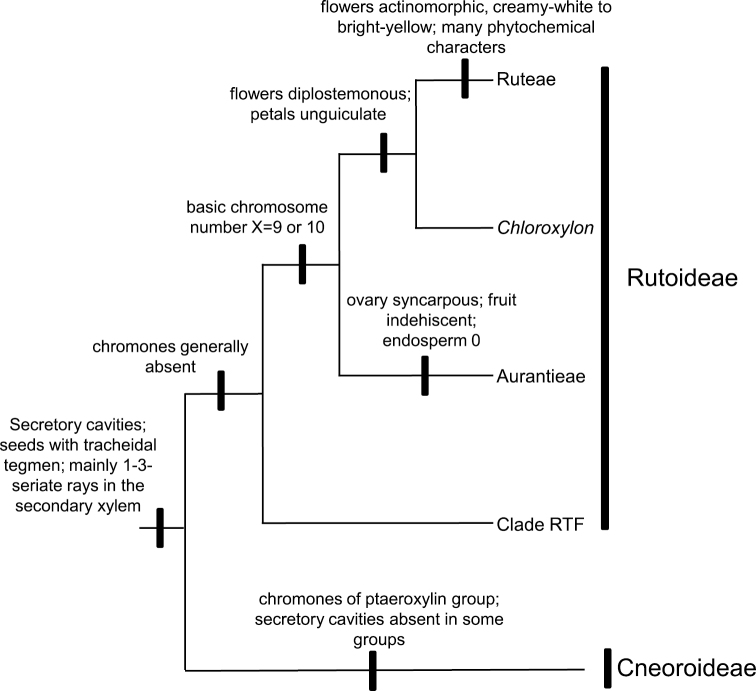
A summary of the phylogenetic relationships of proposed subfamilies in Rutaceae, with some non-molecular characteristics plotted onto a simplified cladogram based on the Bayesian tree. Chloroxylon is doubtfully attached to Aurantieae. Haplophyllum and Cneoridium (both from Englerian Ruteae but closer to Aurantieae that to remaining Ruteae, see Salvo et al. 2010) are missing. Amyris (from Englerian Toddalioideae), also close to Aurantieae (unpublished results) is also missing. The RTF clade corresponds to the bulk of Englerian Rutoideae, plus Toddalioideae and Flindersia. For discussion of characteristics see Waterman and Grundon (1983), Stace et al. (1993), Groppo et al. (2008), and Appelhans et al. (2011, 2012b).